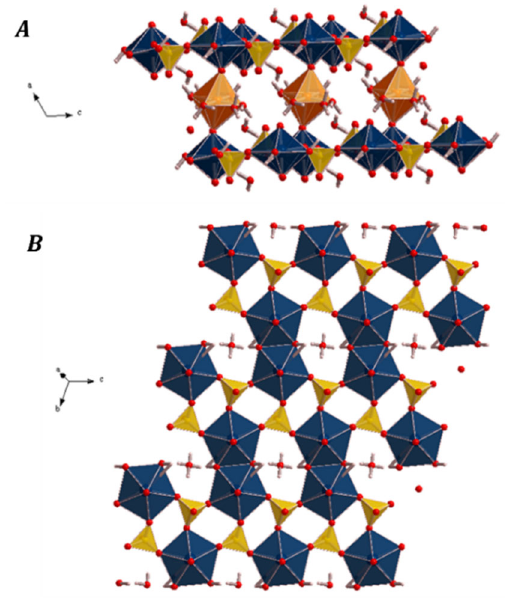
Figure 1. Views of the crystal structure of johannite mineral: ( A ) view of the unit cell from the [0 1 0] direction; ( B ) view of a johannite uranyl sulfate sheet. Color code: Cu—orange; U—blue; S—yellow; O—red; H—white.